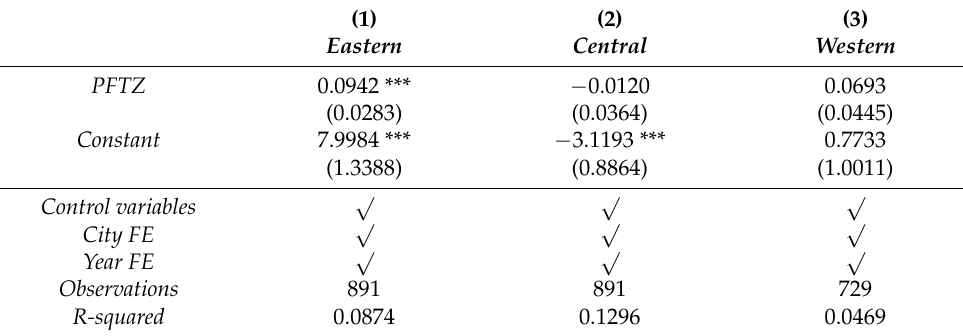
Table 8. The eastern, the central, and the western cities.